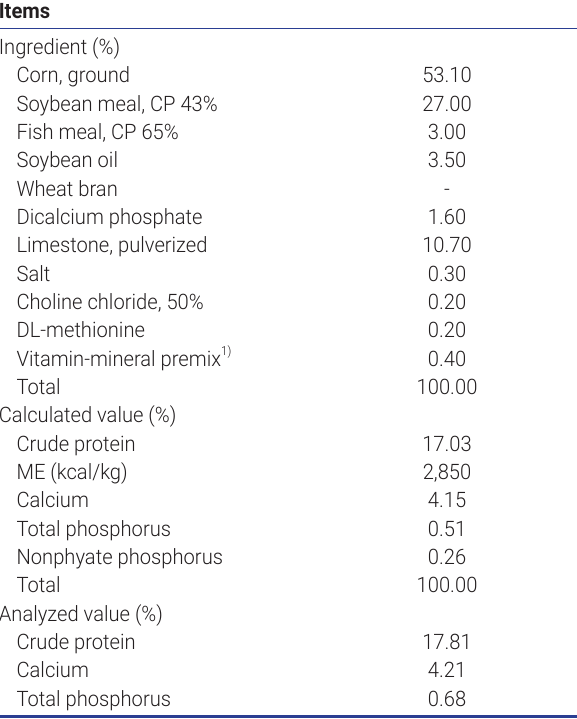
Table 1. Diet formula and compositions offered to Leghorn laying hens in Bacillus subtilis TLRI 211-1